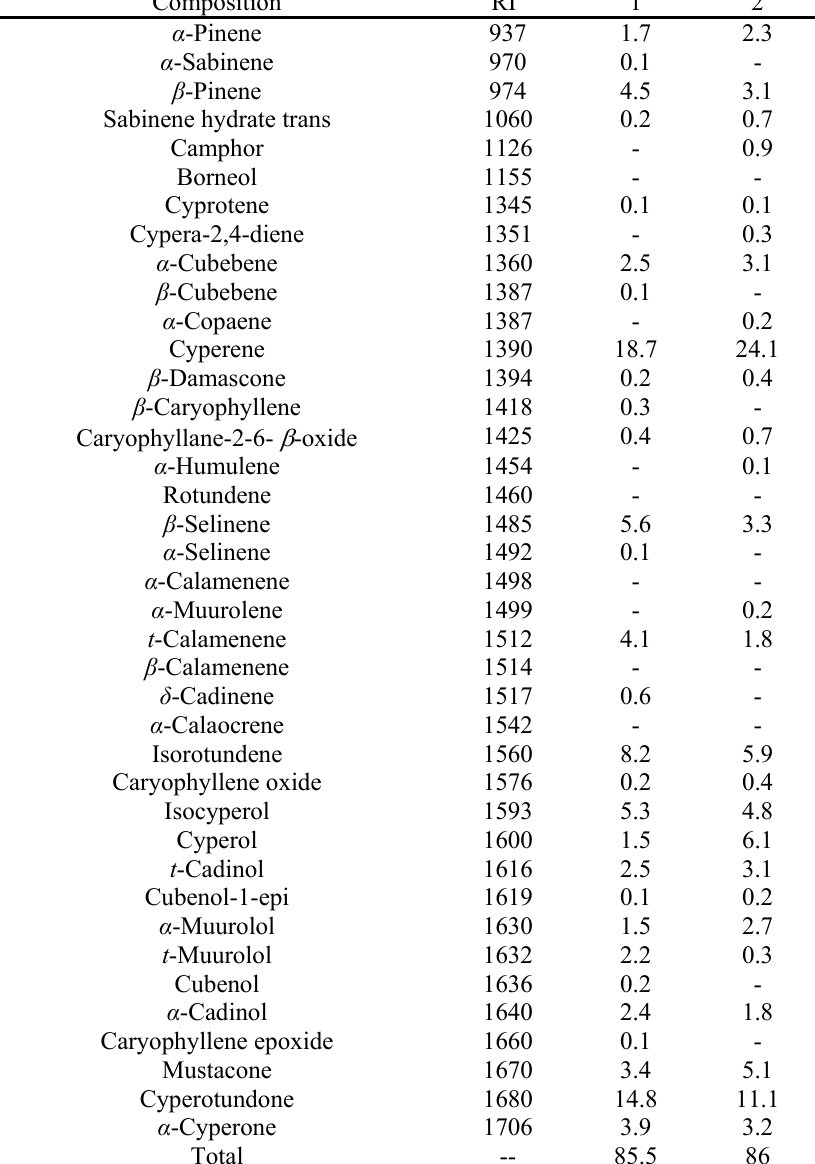
Table 1. Percentage compound of the oil of S. littoralis and S. wardianus